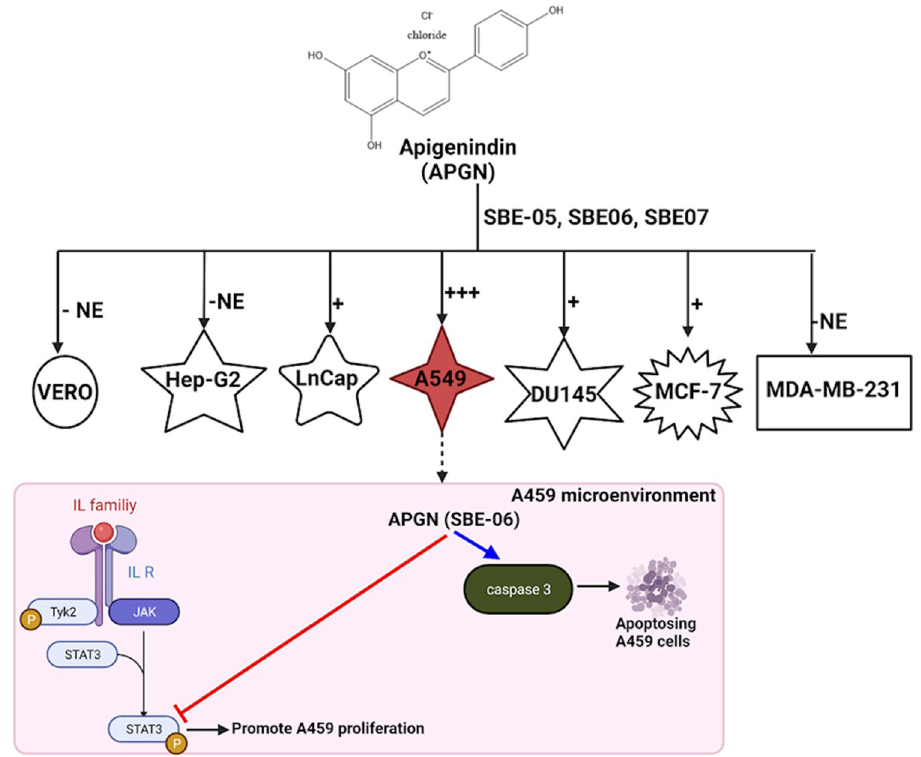
Scheme 1. Proposed mechanism of SBE-06-mediated suppression of A549 cell growth. SBE-06 downregulated the expression of p-STAT3 but upregulated that of caspase 3 in A549 cells. p-STAT3: phosphorylated signal transducer and activator of transcription 3. Created by https:// app. biore nder.